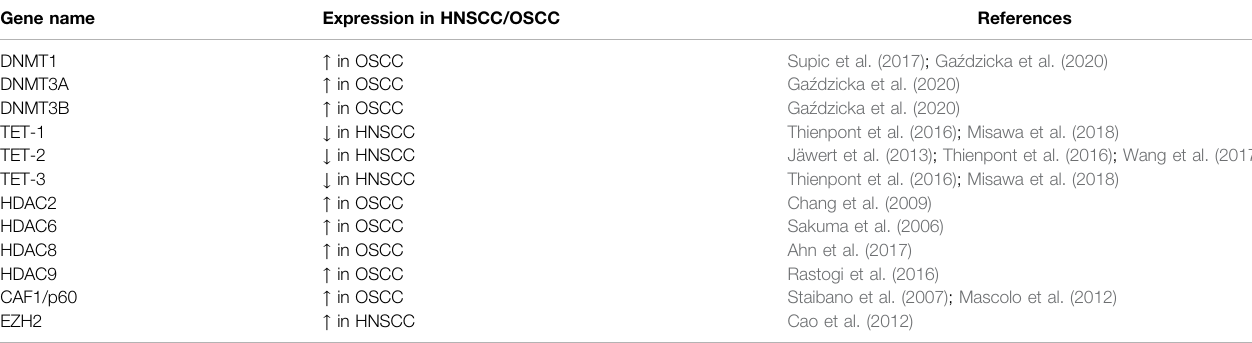
TABLE 2 | Expression of methylation and demethylation enzymes and their association with